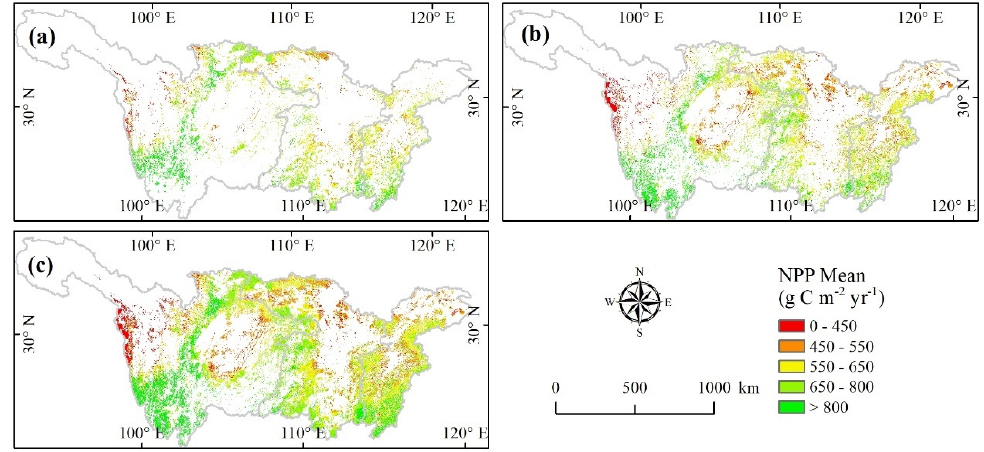
Figure 4. Annual averaged net primary productivity (NPP) of ( a ) the old forest; ( b ) the new forest; ( c ) all forest. The spatial distribution of the forest NPP change trend was obvious regarding re- gional differences (Figure 5). The overall trends of F new and F old ranged from − 61.10 g C m − 2 year − 1 to 36.40 g C m − 2 year − 1 , and − 56.93 g C m − 2 year − 1 to 31.94 g C m − 2 year − 1 , respec- tively. Besides, trends of F old and F new displayed similar spatial characteristics, with in- creasing trends in most regions of the study areas. NPPs of F old and F new increased in 29.24% and 52.05% of the forest area, respectively (Figure 5b,d), and the significant in- creasing trend of F old and F new ( p < 0.05) accounted for 14.36% and 30.65% of this area, respectively (Figure 5b, d). In contrast, the significant decreasing trend ( p < 0.05) in NPP